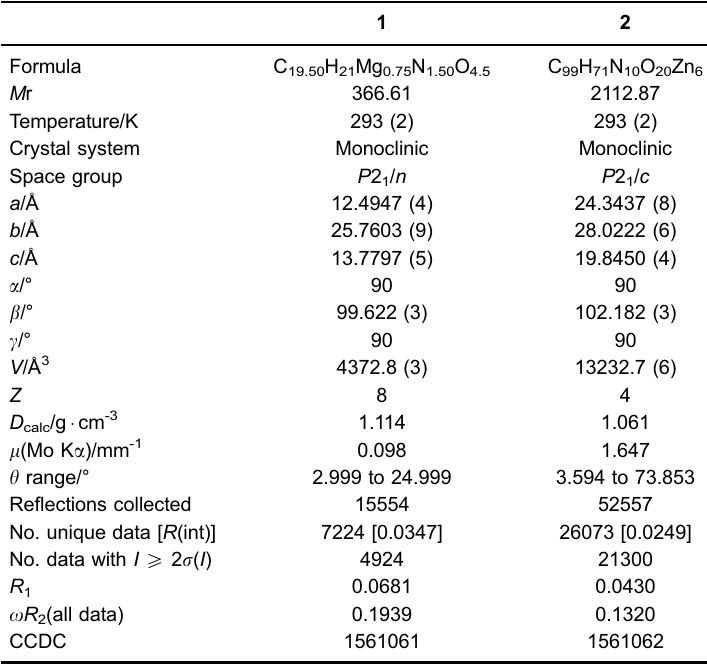
Table 1. Crystal data and structure re fi nements for compounds 1 and